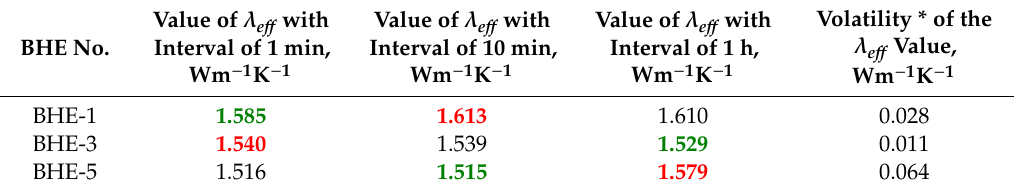
into consideration sensors uncertainty the values of λ e ff has uncertainty equals ± ∆ λ e ff = 0.032 Wm − 1 K − 1 .